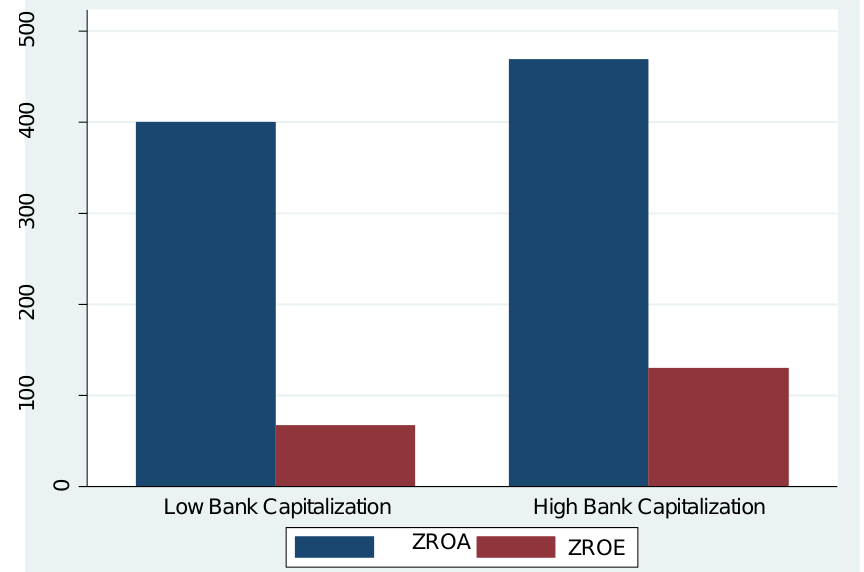
Figure 3. Average of Bank Stability by Bank